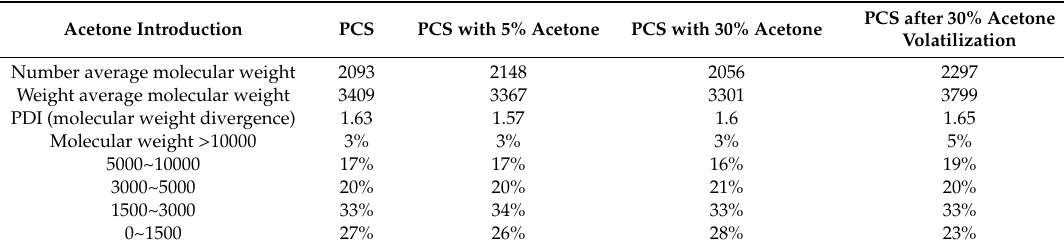
Table 1. Gel permeation chromatography (GPC) test